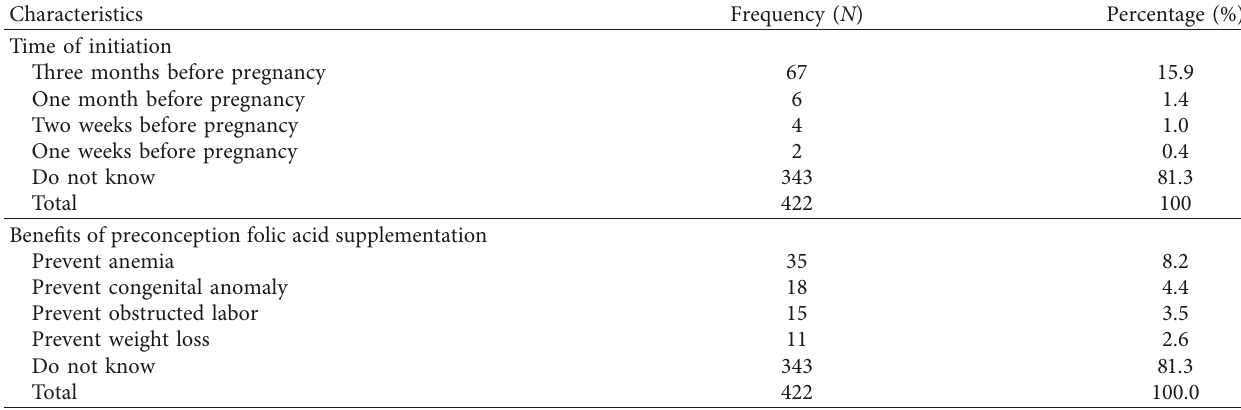
Table 3: Distribution of women’s awareness on the benefit and time of initiation for on preconception folic acid supplementation in Adet, Gojjam, Northwestern Ethiopia, 2016 ( n � 422).